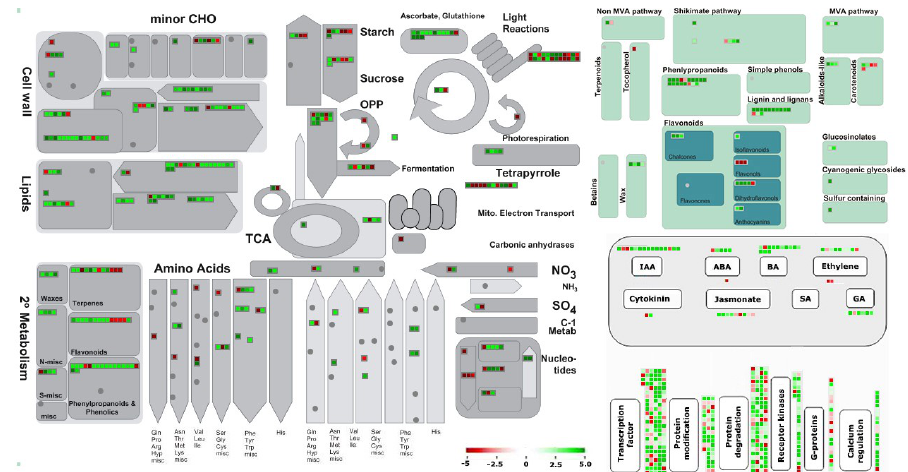
Figure 5. MapMan visualization of changes in transcript levels over the main metabolic process in CBCVd-infected compared with mock inoculated hop. The log 2 fold changes of significantly differentially expressed genes were imported and visualized in MapMan. Red and green displayed signals represent a decrease and an increase in transcript abundance, respectively, in CBCVd-infected relative to the mock inoculated samples of hop. The scale used for coloration of the signals (log 2 ratios) is